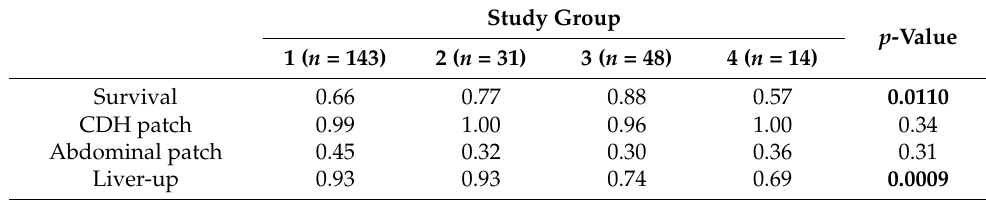
Table 2. Survival and frequencies of CDH patch, abdominal patch and liver-up phenomenon. Study